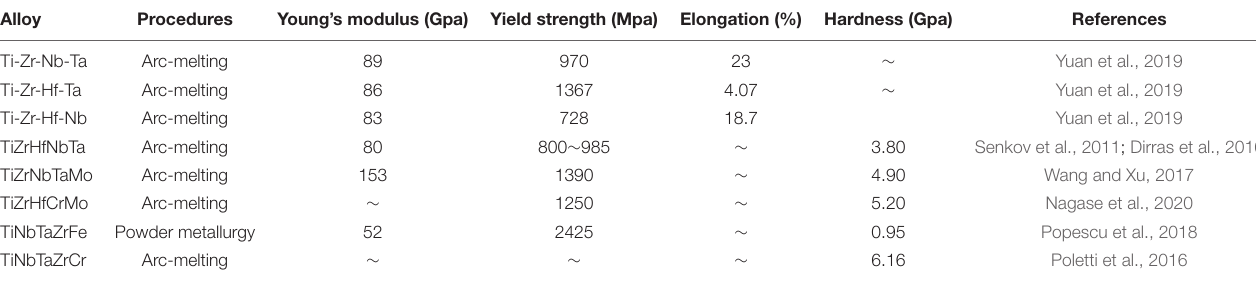
TABLE 2 | Mechanical properties of HEA prepared by arc-melting and powder